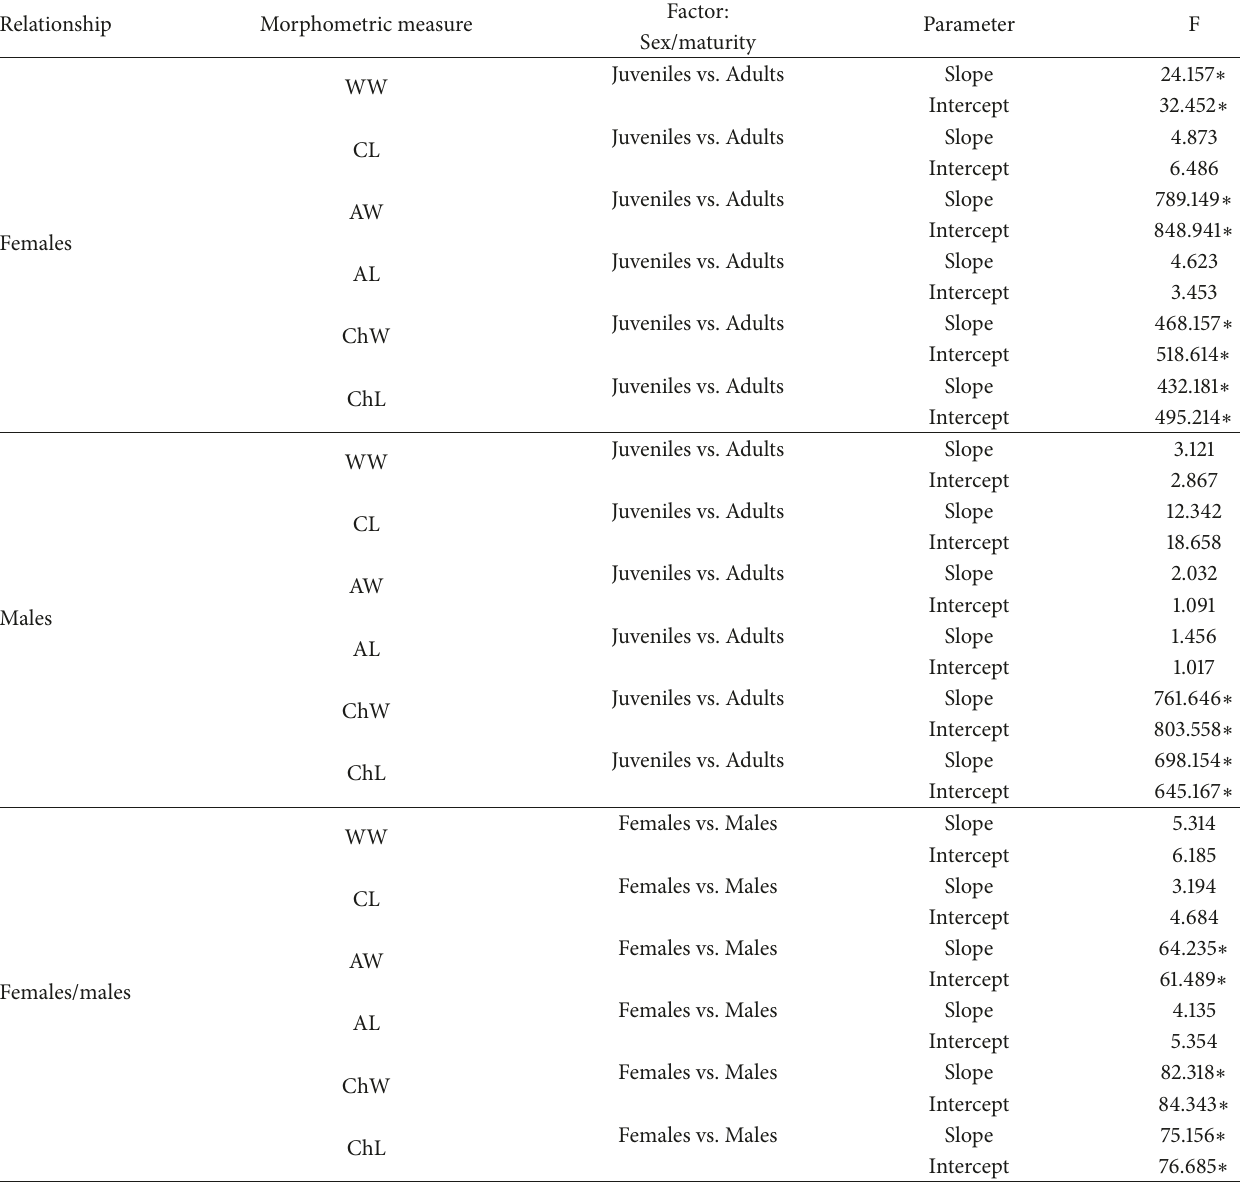
Table 1: Results of allometric relationships studied in Potamon algeriense : analyses of covariance (ANCOVA) carried out to test slope and intercept for both sexes that indicate the beginning of maturity in relation to body size. Significance was indicated by an